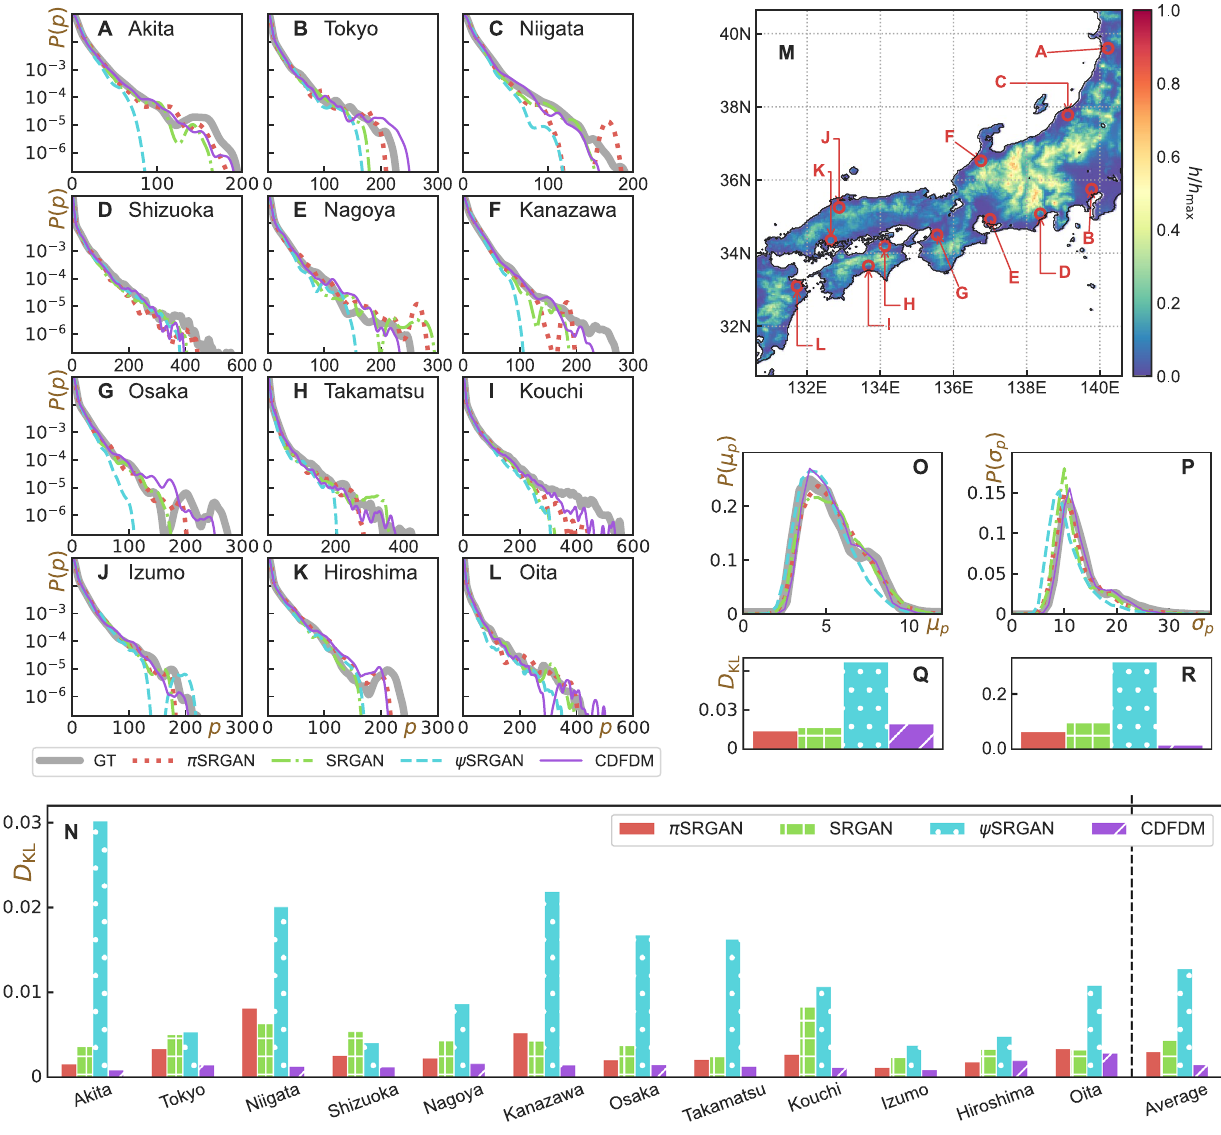
Figure 3. Statistics of precipitation. ( A – L ) The probability distribution functions (PDFs) P ( p ) as a function of the precipitation p at each site. 12 representative sites are chosen from all over Japan. The different ranges of the abscissa reflect the regional characteristics. See SI Appendix for the technical details in processing the PDFs. ( M ) The normalized topographic information and the locations of 12 sites of panels ( A – L ). ( N ) Bar plot of the values of the Kullback–Leibler divergence of DS methods for P ( p ). ( O , P ) The PDFs of the mean µ p and standard deviation σ p of the precipitation over all the test data at each site; here the values of µ p and σ p at different sites serve as samples of the PDFs. ( Q , R ) Bar plot of the values of the Kullback–Leibler divergence for P (µ p ) and P (σ p )